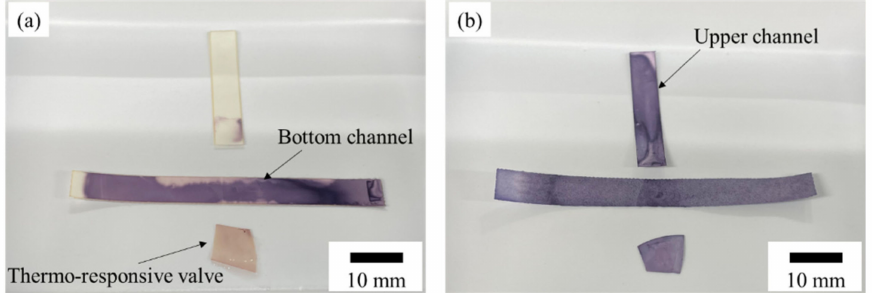
Figure 9. Flow channel and valve immersed in BCIP/NBT solution after ALP flowed through the valve performance evaluation system. ( a ) ALP flowed without heating the valve, and ( b ) ALP flowed in the case of valve